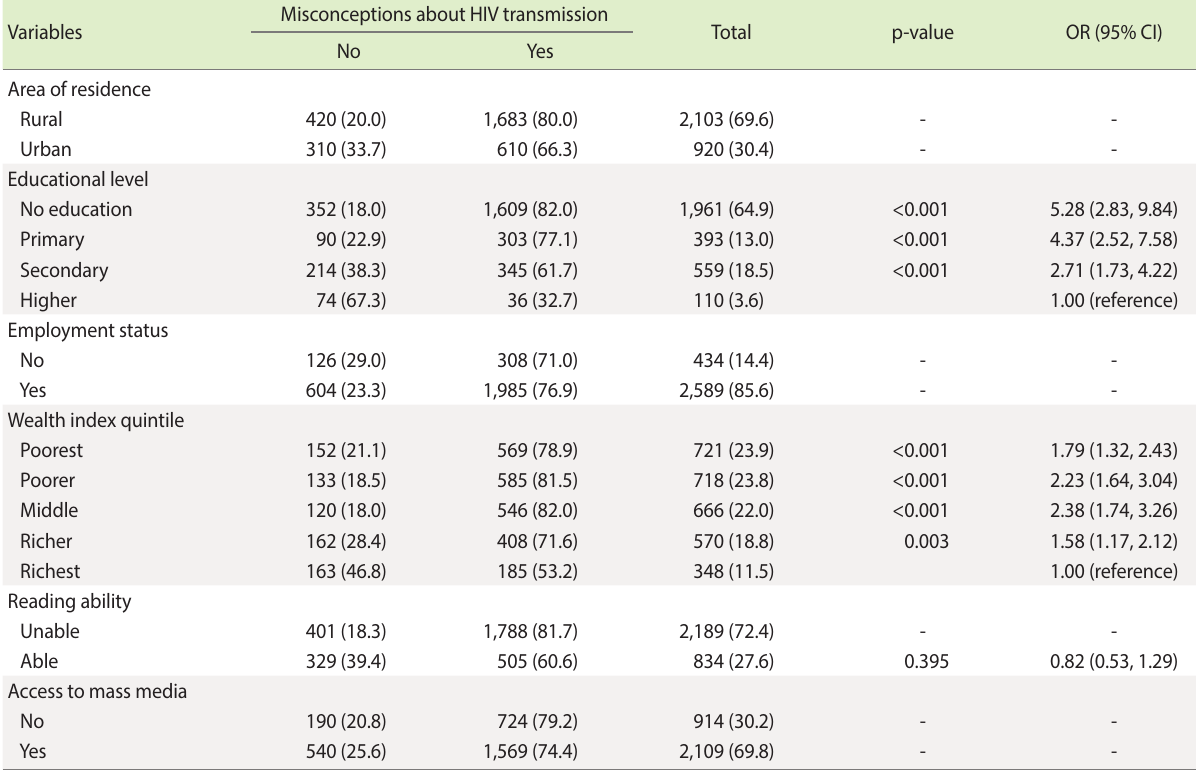
Table 2. Descriptive statistics and multivariable regression model exploring variation in misconceptions about HIV transmission